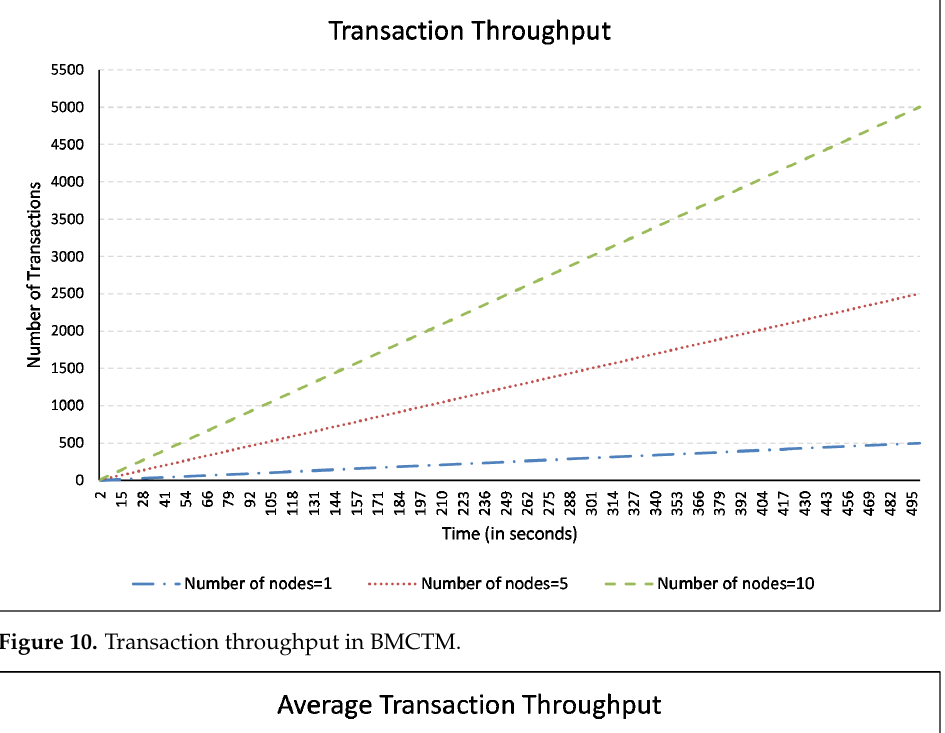
Figure 10. Transaction throughput in BMCTM.